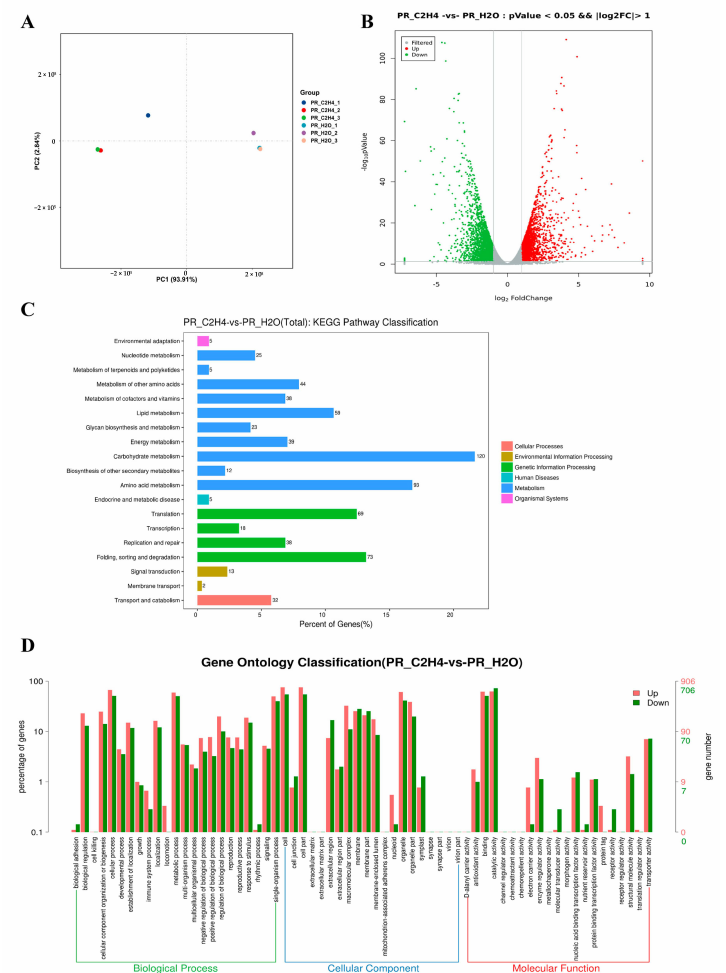
Figure 4. Qualitative and quantitative analysis of transcriptomics data . ( A ) The principal com- ponent analysis (PCA) of different samples. PR-C 2 H 4 -1, PR-C 2 H 4 -2, and PR-C 2 H 4 -3 are the three samples of primordia that underwent ethylene treatment. PR-H 2 O-1, PR-H 2 O-2, and PR-H 2 O-3 are three control samples that underwent water treatment. ( B ) The volcano plot of differentially expressed genes. ( C , D ) are KEGG pathway classification and Gene Ontology classification of differentially expressed